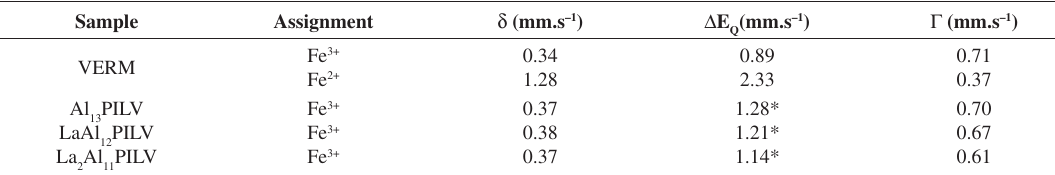
Figure 5. Mössbauer spectra of (a) VERM, (b) Al Table 3. Hyperfine parameters vermiculite at different steps.